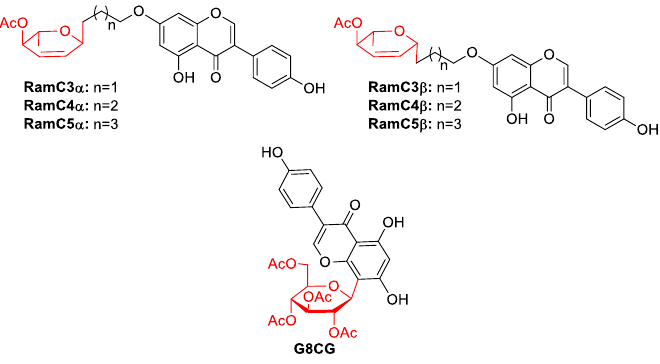
Figure 14. Genistein C-glycoconjugates .